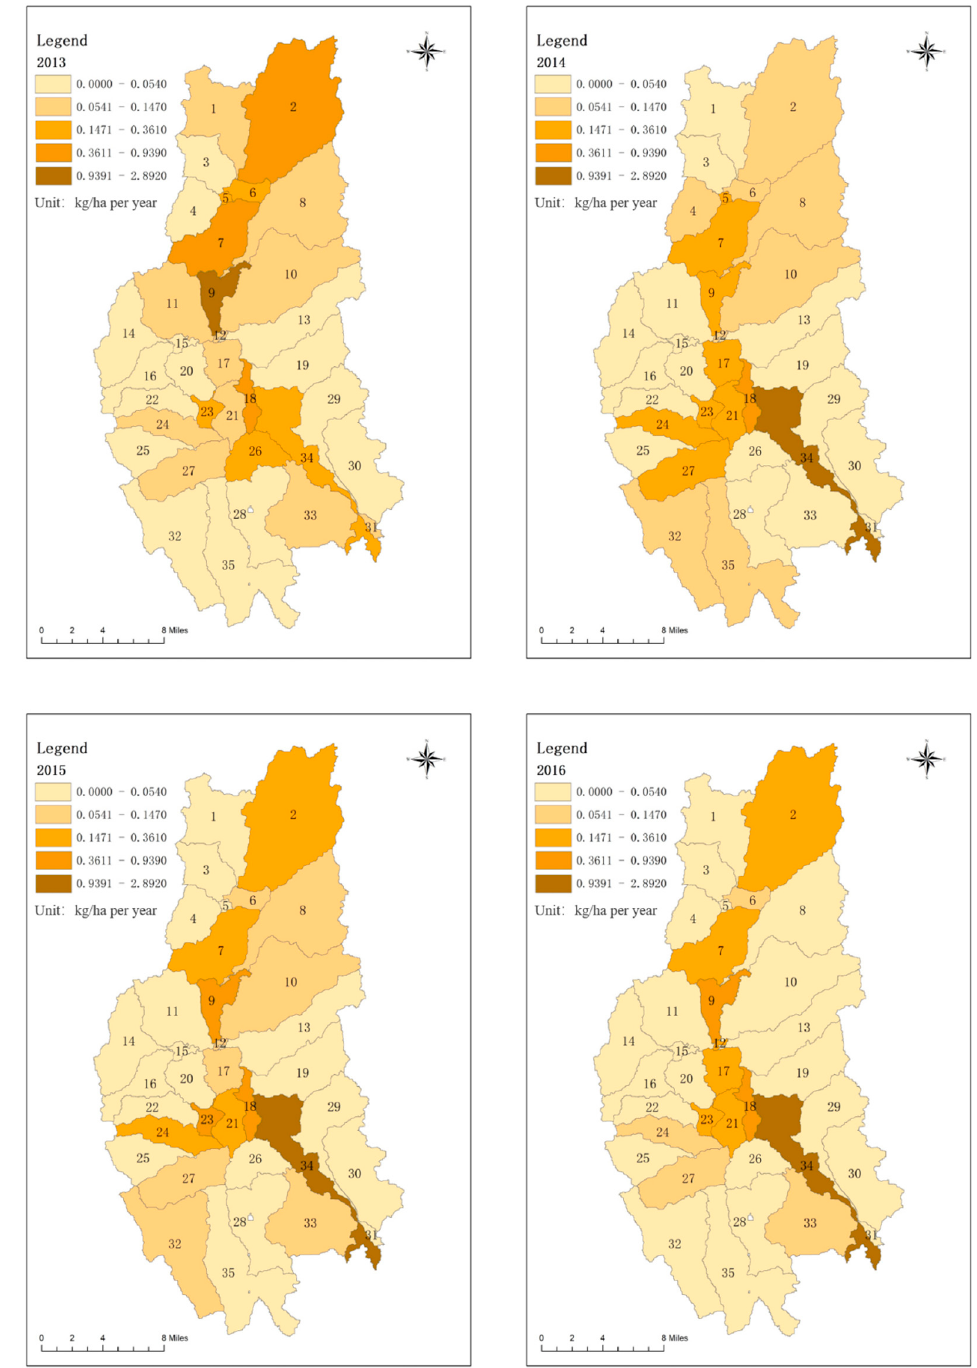
Figure 6. Sub-basin P export to Erhai Lake from 2013 to